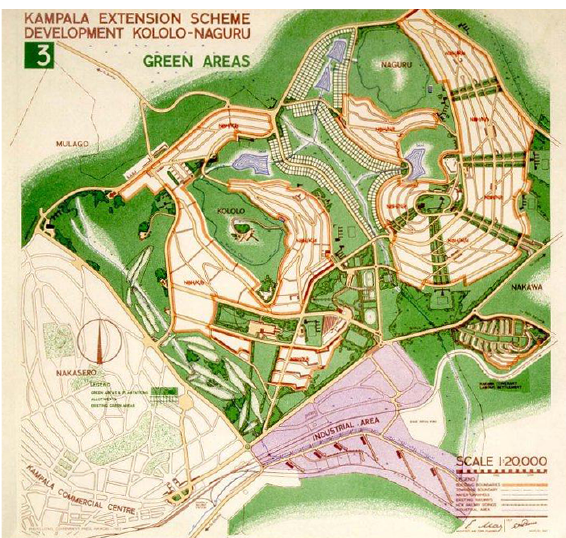
Figure 13. Development Kololo-Naguru green areas. Source: May (1947, Appendix).